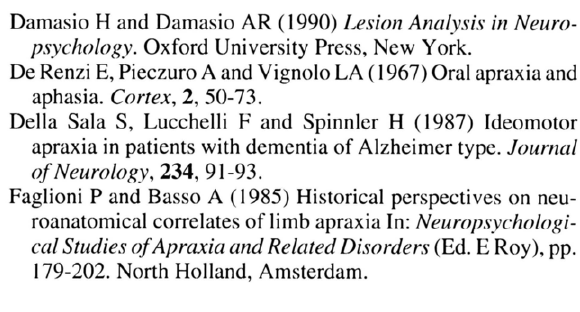
matter of speculation. Several different degenerative